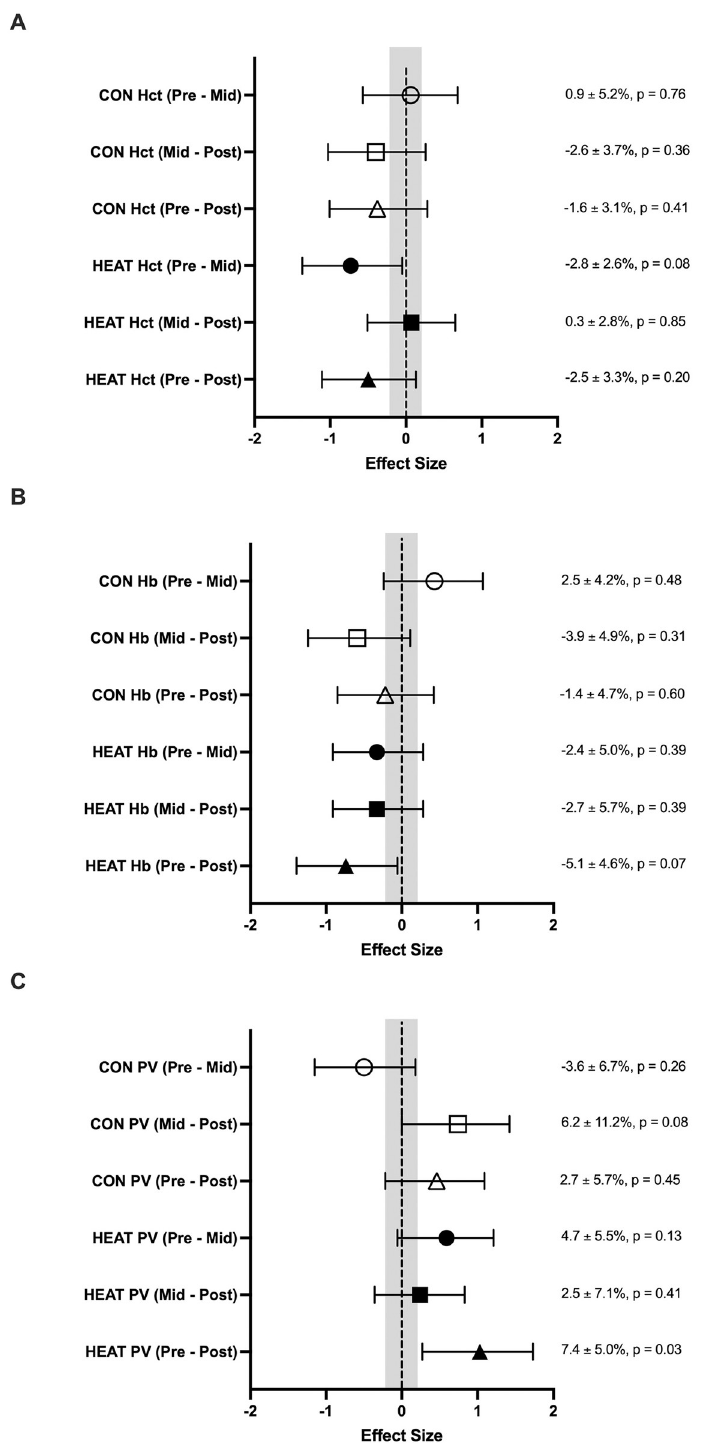
Fig 2. Within-group changes (Mean ± 90% CI) across the intervention (Pre, Mid, Post) for both HEAT and CON in Hb (A), Hct (B) and PV (C). Shaded area represents trivial change (d < 0.2). The corresponding within-group % change and p-values are also